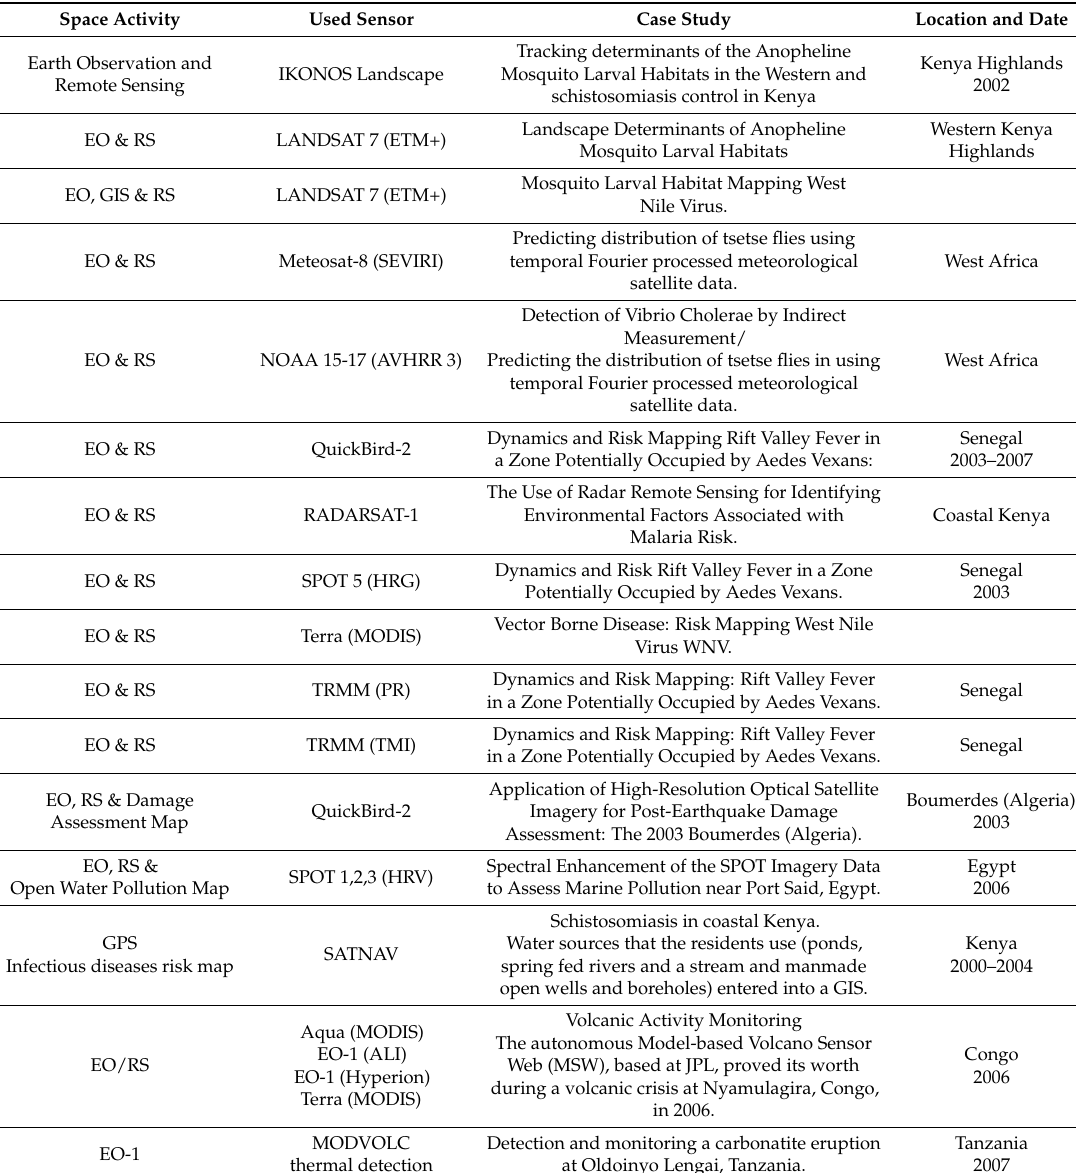
Table 2. Geospatial Products, Space Applications and Disaster/Conservation Management over